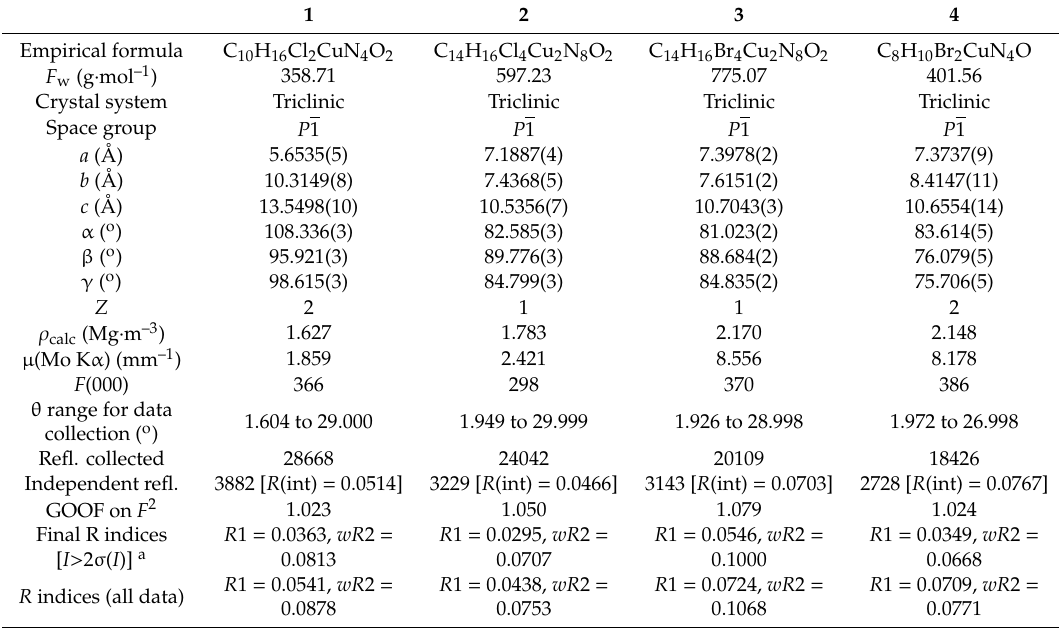
Table 5. Crystal data and structure refinement for 1 – 4